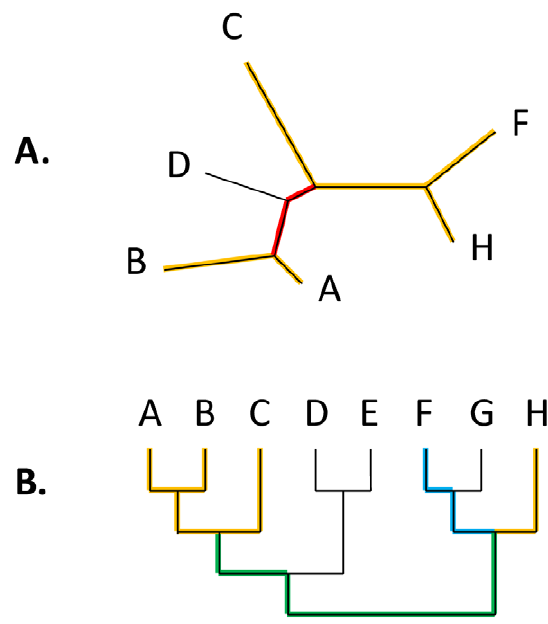
Figure 1. Gene trees and the supertree. A. A gene tree (GT). After the comparison with the supertree (ST), the GT is reduced to the maximum agreement subtree (MAST, highlighted in yellow). The reduced GT edge highlighted in red corresponds to two edges in the original GT. B. Supertree (ST). Mapping of the reduced GT onto the ST is highlighted; two sections of ST that consist of multiple edges mapping to a single edge of the reduced GT are highlighted in blue and green, respectively.